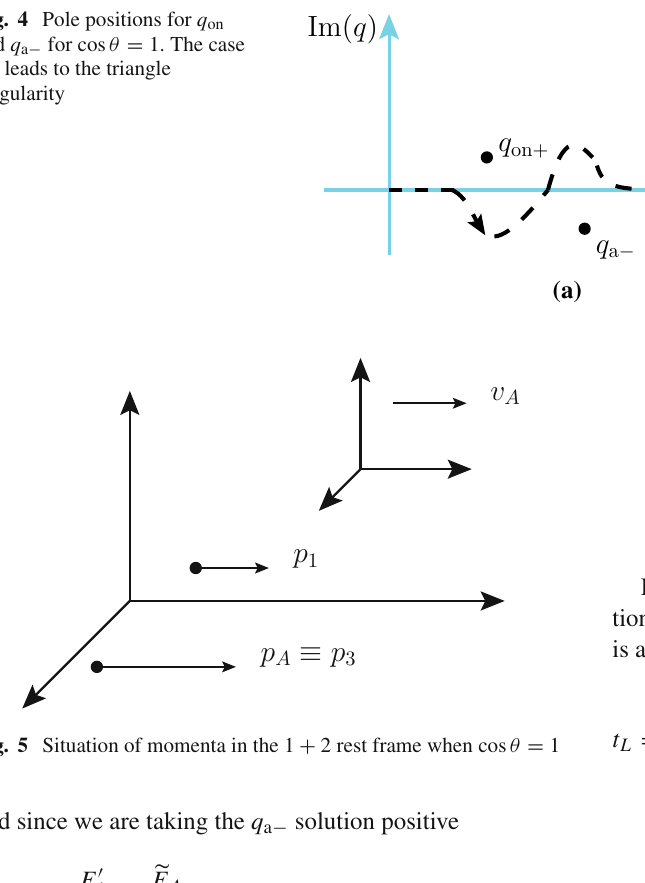
Fig. 4 Pole positions for q on and q a − for cos θ = 1. The case (b) leads to the triangle singularity